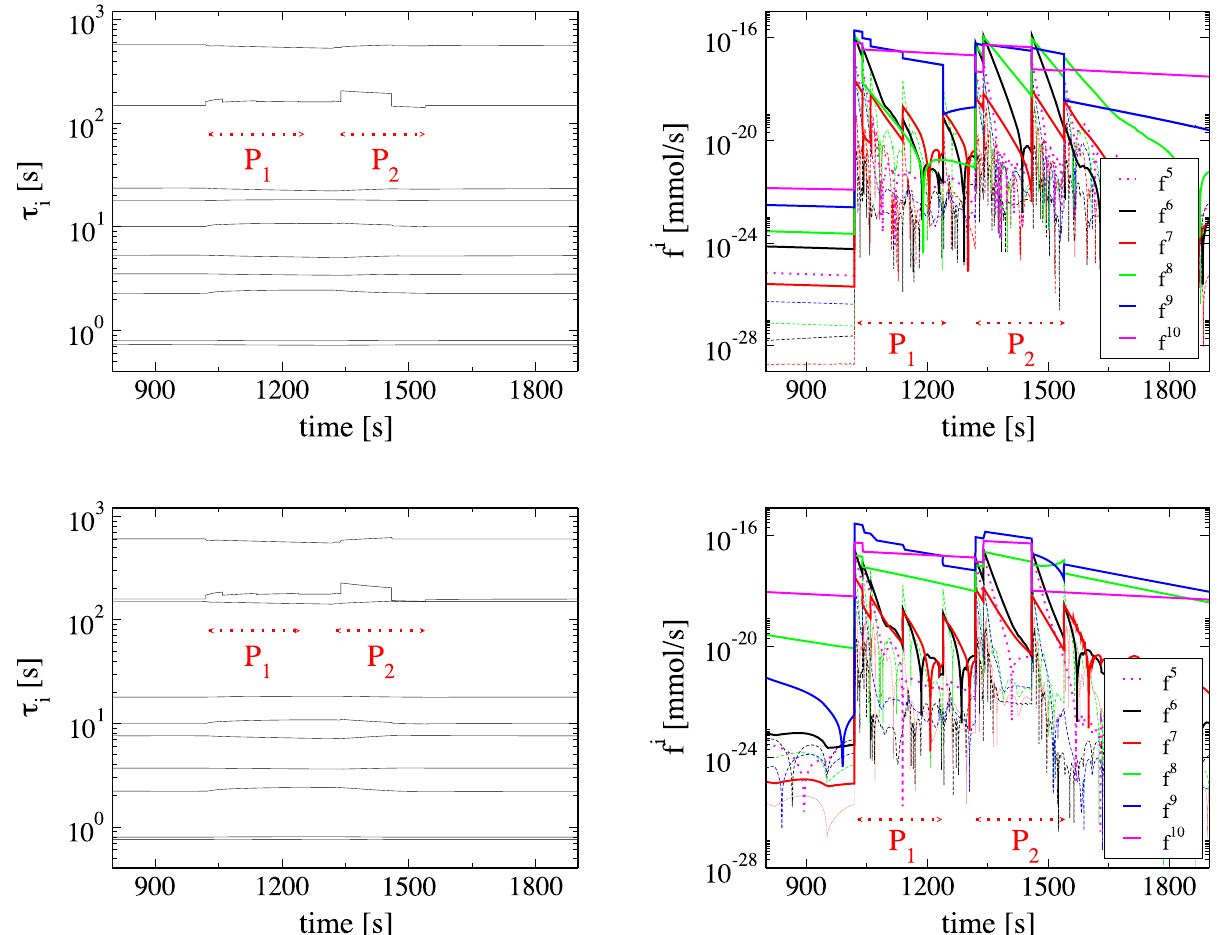
Fig 2. The timescales and the amplitudes. Evolution of the time scales τ (left) and the amplitudes f i (right) of the CSP modes during neuronal i activation, for the ANLS (top) and NALS (bottom) cases. P 1 and P 2 represent the periods of neuronal activation that are examined in detail. The dotted and solid lines in the figures on the right denote the first 5 and the last 5 amplitudes f i ,